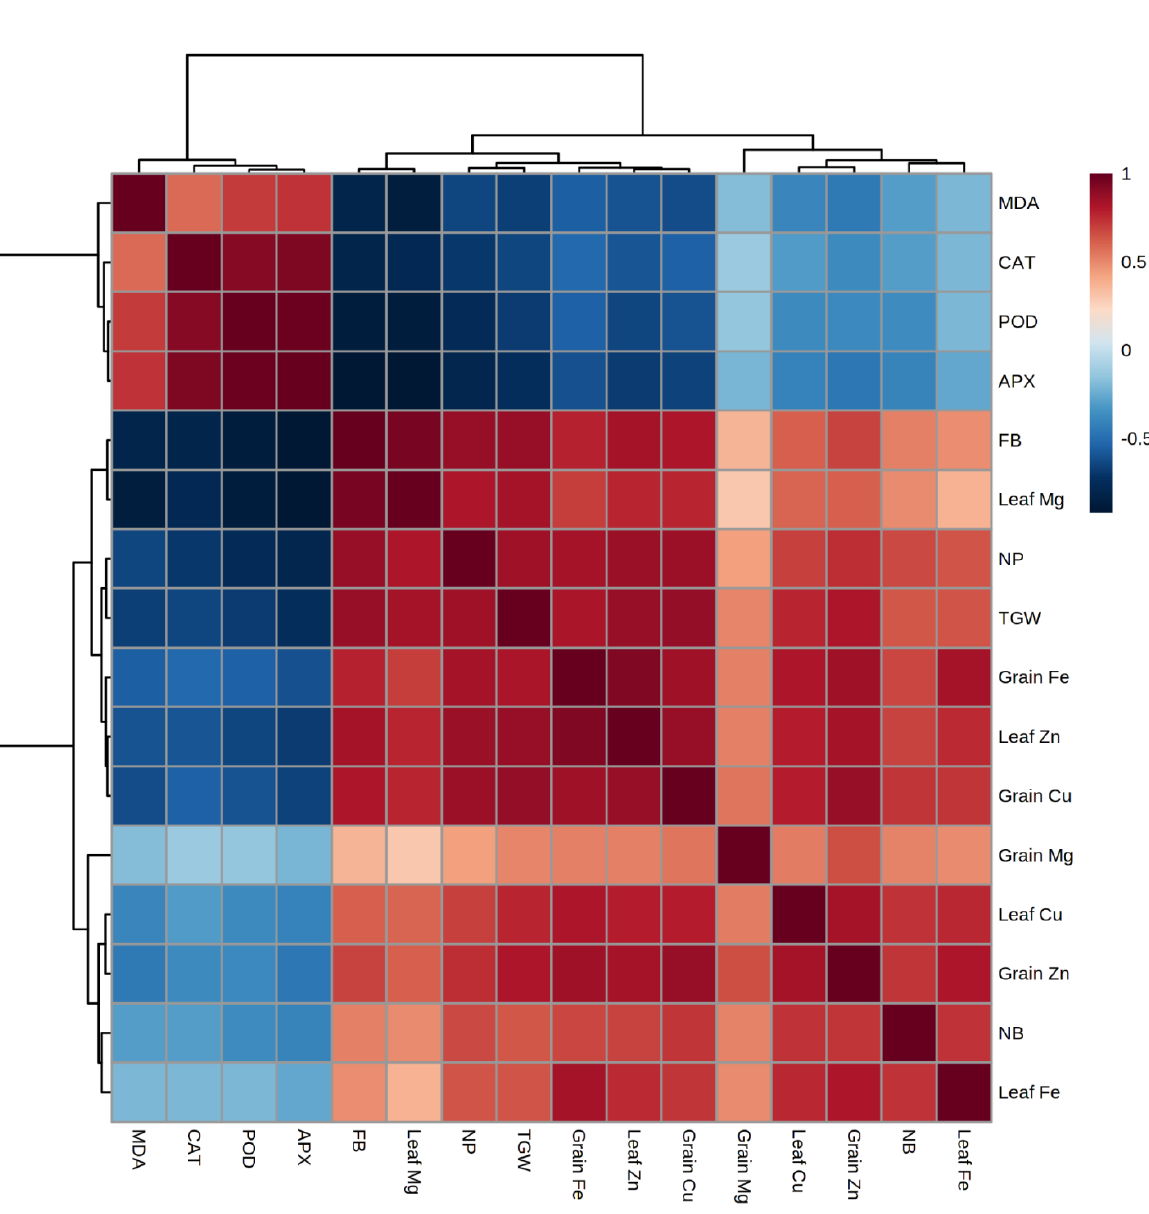
Figure 3. Pearson correlation with various colors showing the strength of relationship of all observed parameters. Side bar having gradual intensity of brown and blue colors depicts strength of association either positive or negative, respectively, according to the color pattern. The complete forms of the abbreviations used for variables are FB, Fresh biomass; NP, Number of pods; NB, Number of branches; TGW, Thousand grain weight; Mg, Magnesium; Fe, Iron; Zn, Zinc; Cu, Copper;